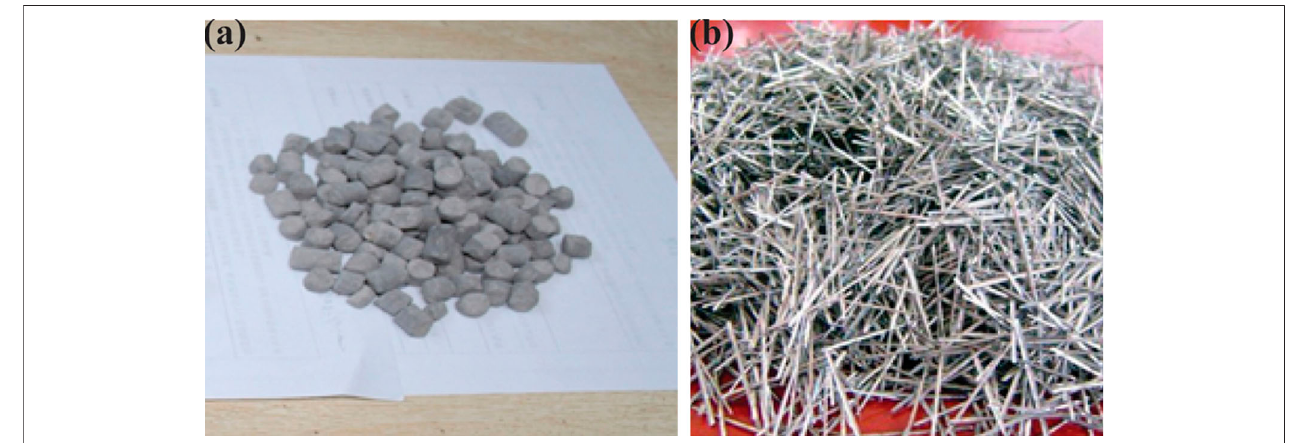
FIGURE 1 | (A) Coal gangue ceramsite as lightweight aggregates, and (B) steel fi bers used in this study.